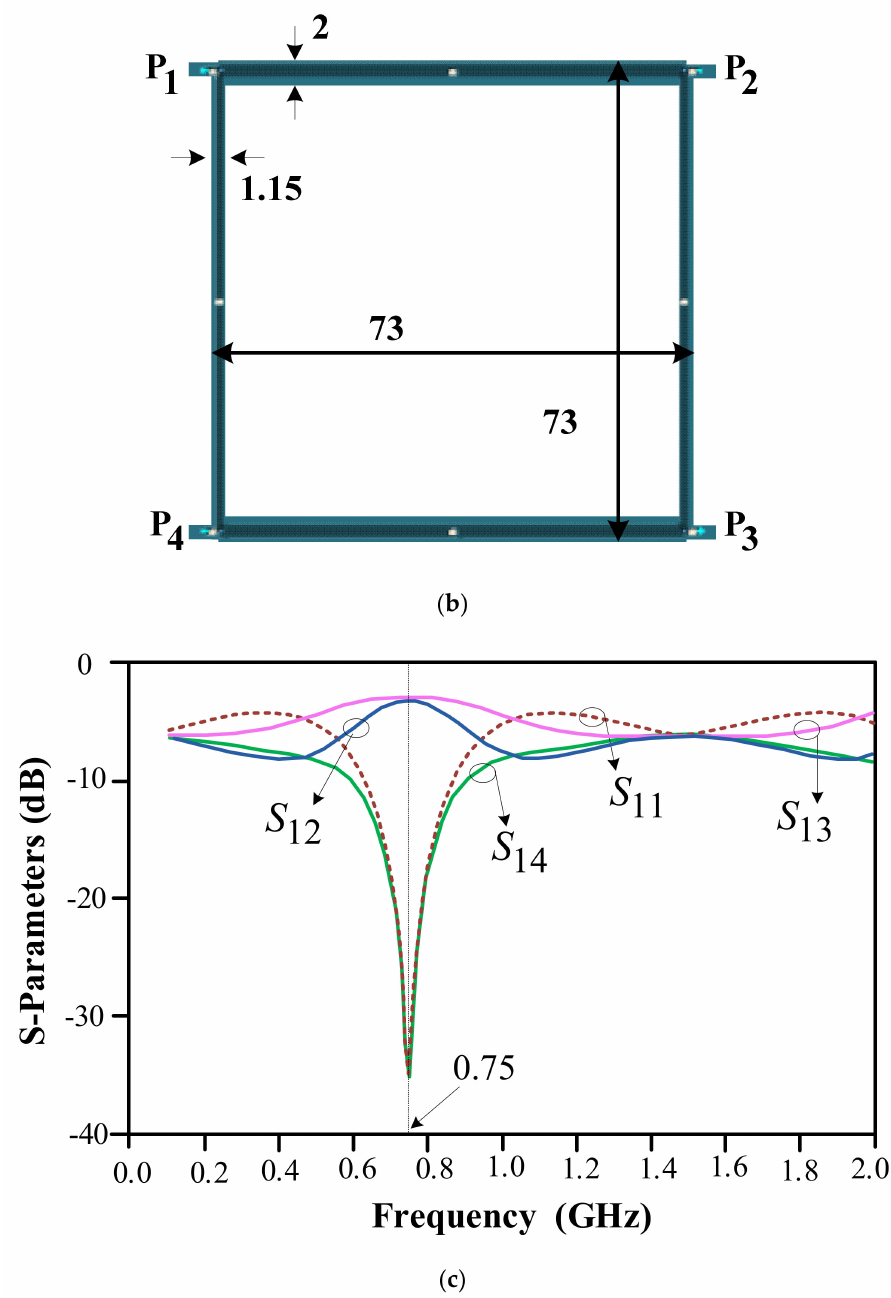
Figure 1. Conventional 750 MHz BLC: ( a ) schematic diagram, ( b ) layout, and ( c ) frequency response. Dimensions are in